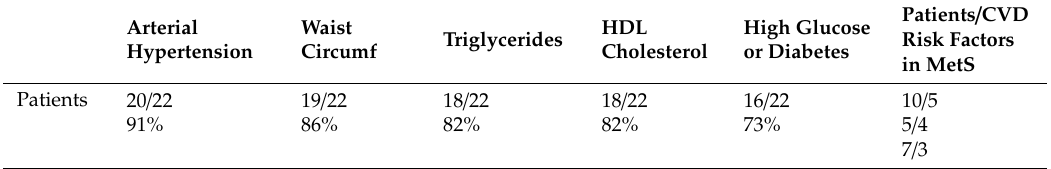
Table 2. Relative participation and percentage of the five CVD risk factors in the MetS